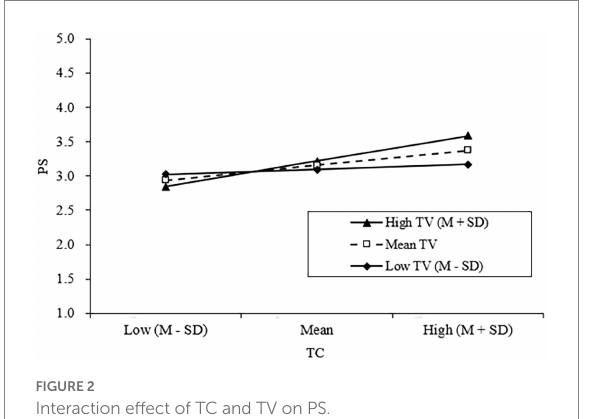
FIGURE 2 Interaction effect of TC and TV on PS.